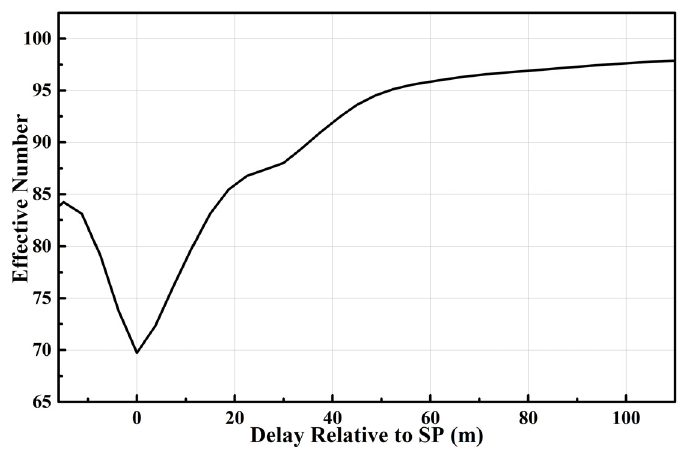
Figure 8. Effective incoherent average number relative to SP.